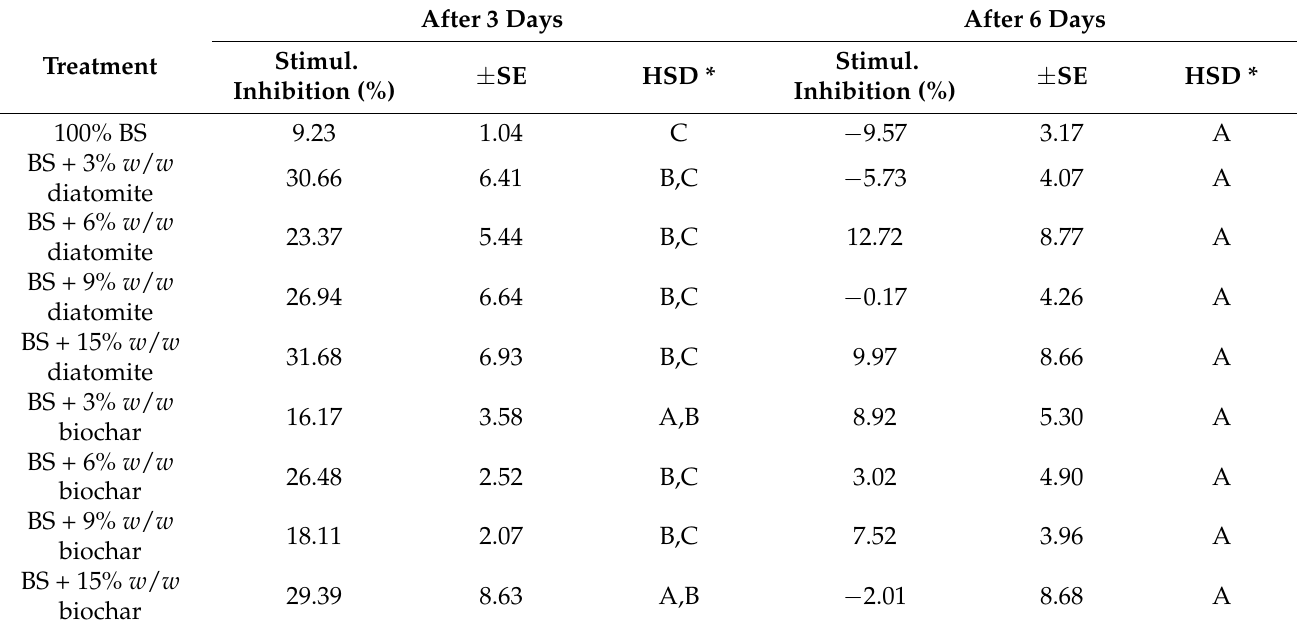
Table 4. Comparison of all average of stimulation/inhibition of root growth of Sinapis alba L. after 3 and 6 days of exposure to burnt soil supplemented with diatomite or biochar in increasing proportions (compared to OECD soil).